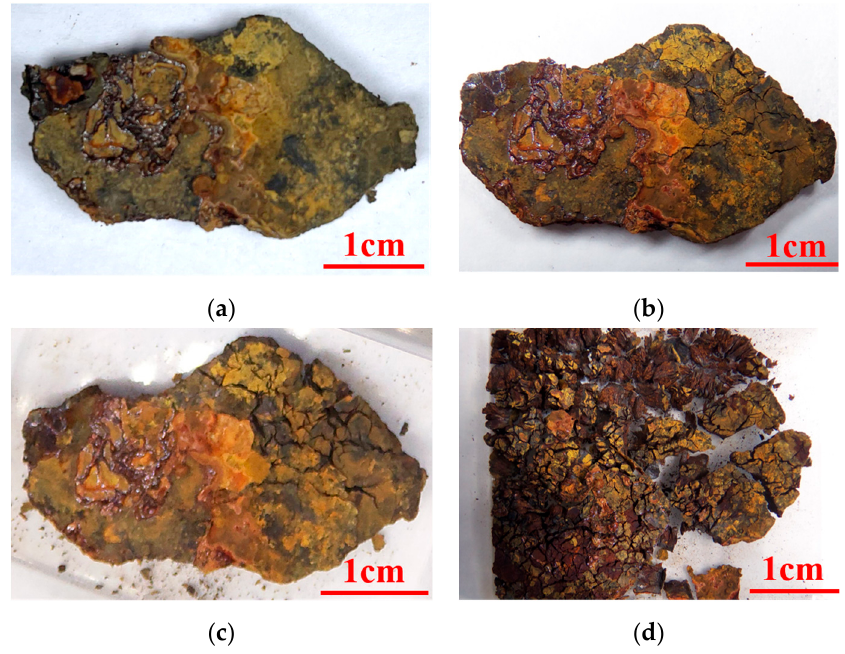
Figure 2. The pulverization phenomenon of the iron pot sample. ( a ) Initial. ( b ) 15 days later. ( c ) 30 days later. ( d ) 90 days later.